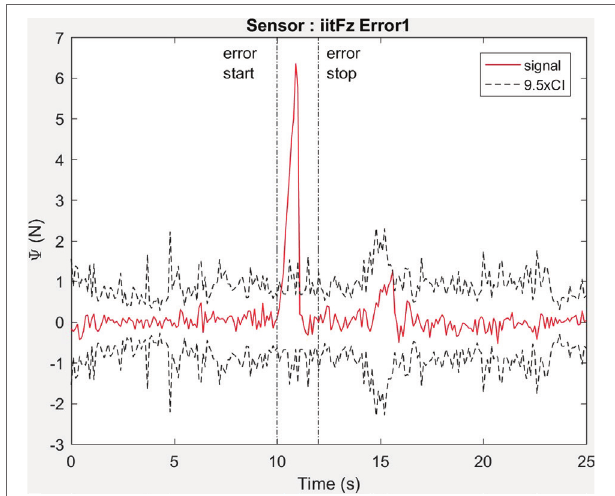
FigUre 10 | load cell sensor measurement in z -axis while dressing the bare mannequin showing a single sample of error data (solid) shown with respect to 9.5 times the confidence interval ( n = 10) of the reference data (dashed) . Vertical lines (dot dash) show approximate start and stop of the error